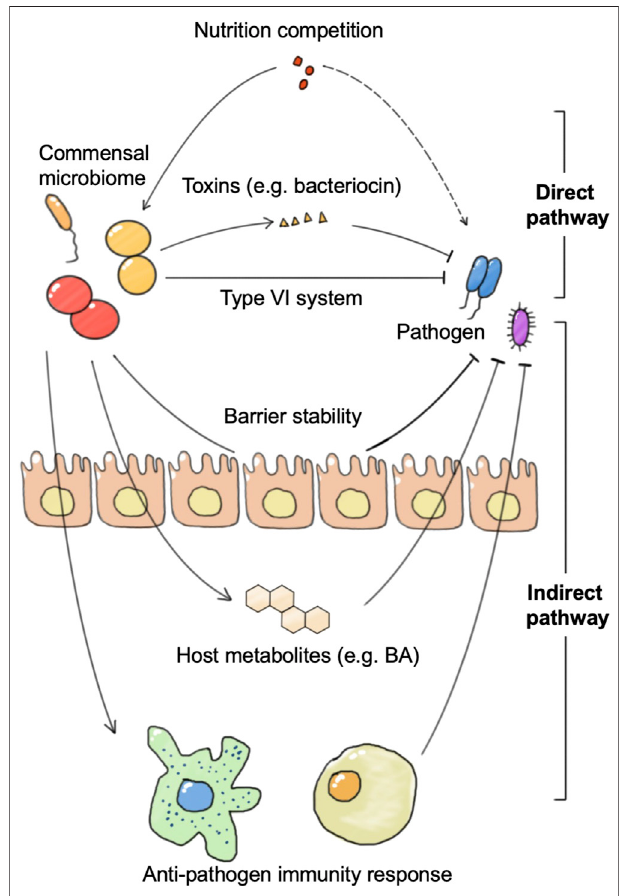
FIGURE 3 | The connections between the commensal microbiome and pathogen.The commensalmicrobiome representscolonization resistance via direct and indirect pathways. The direct pathway includes nutrition utilization advantageagainstpathogensanddirectkillingofpathogensbytoxinsor the type VI secretion system. The indirect pathway refers to the activation of the host immune system or anti-pathogen metabolite production, and the enhancement of barrier